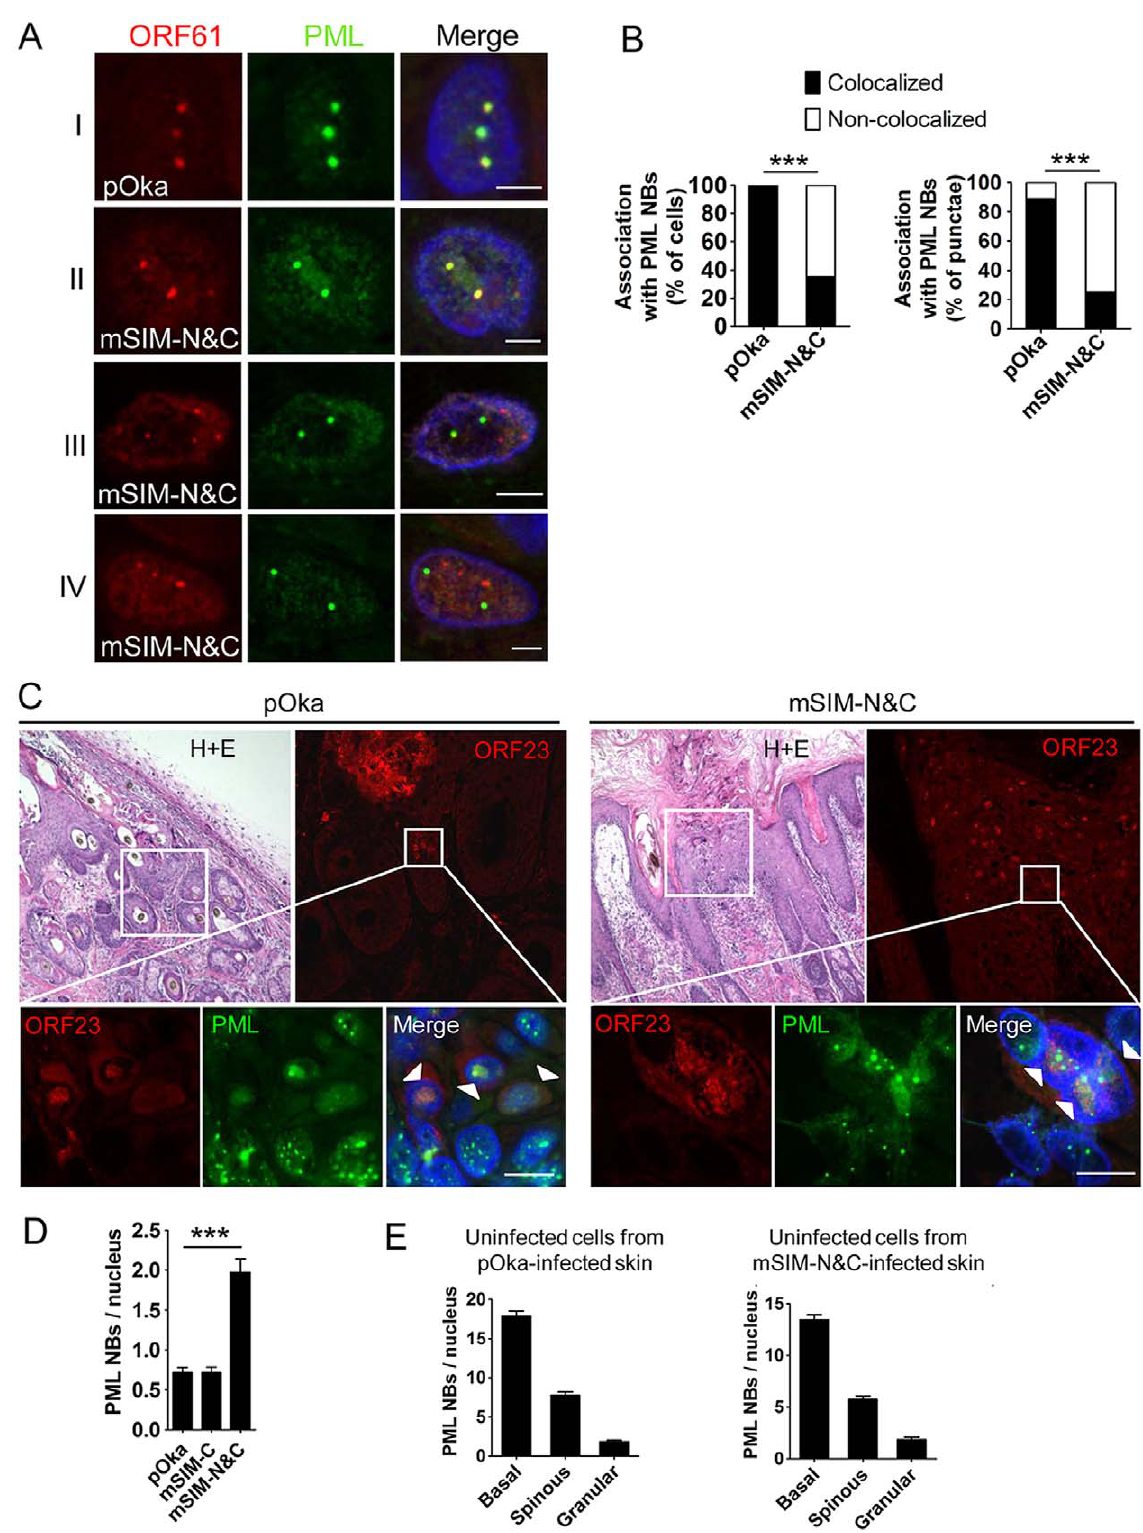
Figure 7. ORF61 SIMs are required for ORF61 association with and dispersal of PML NBs in skin cells invivo . (A) Confocal microscopy of pOka- or pOka-mSIM-N&C-infected skin cells that were stained for ORF61 (red), PML (green), and nuclei (blue). The images show association of ORF61- positive puncta with PML NBs in newly infected cells. Scale bars: 2.5 m m. (B) Quantitation of ORF61/PML NB association in pOka- or pOka-mSIM-N&C- infected cells that had ORF61-positive puncta. The left panel shows percentage of cells that show/did not show ORF61 colocalization with PML NBs (pOka, N=47; mSIM-N&C, N=46; ***, p , 0.0001 by Chi-square). The right panel shows percentage of ORF61-positive puncta colocalized/not colocalized with PML NBs (pOka, N=167; mSIM-N&C, N=202; ***, p , 0.0001 by Chi-square). (C) Confocal microscopy of pOka- or pOka-mSIM-N&C-